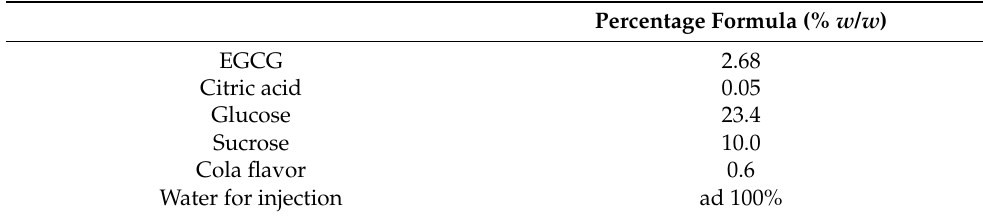
Table 1. Composition of the